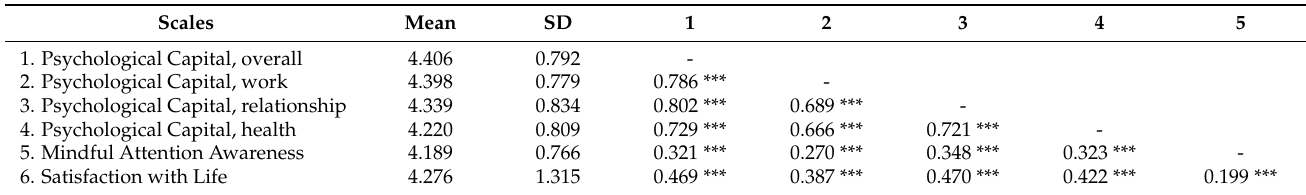
Table 6. The means, standard deviations, and bivariate correlations between the PCQ-12, the MAAS, and the SWLS.